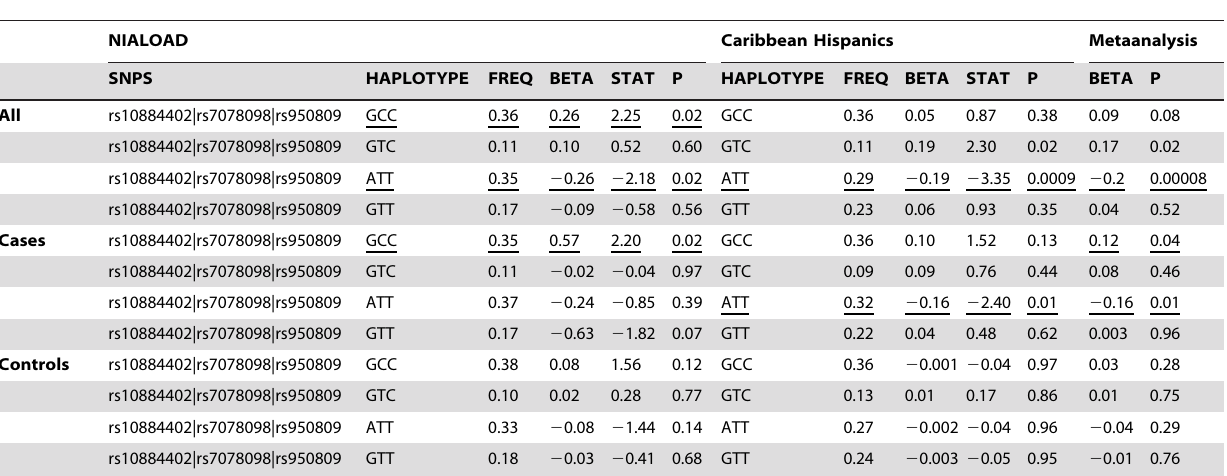
Table 3. Haplotype associations of SNPs rs10884402, rs7078098 and rs950809 with the memory savings